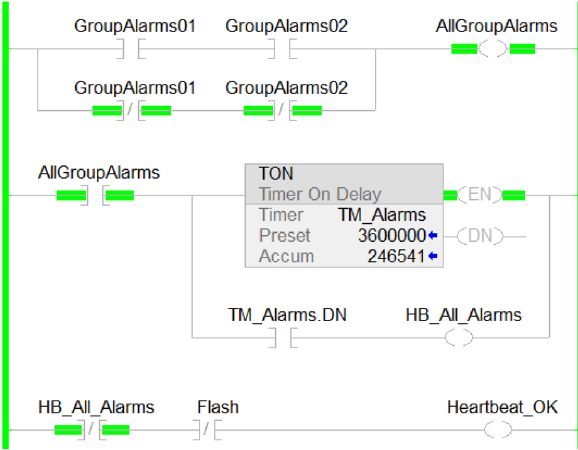
Fig. 27 Heartbeat setup based on groups of